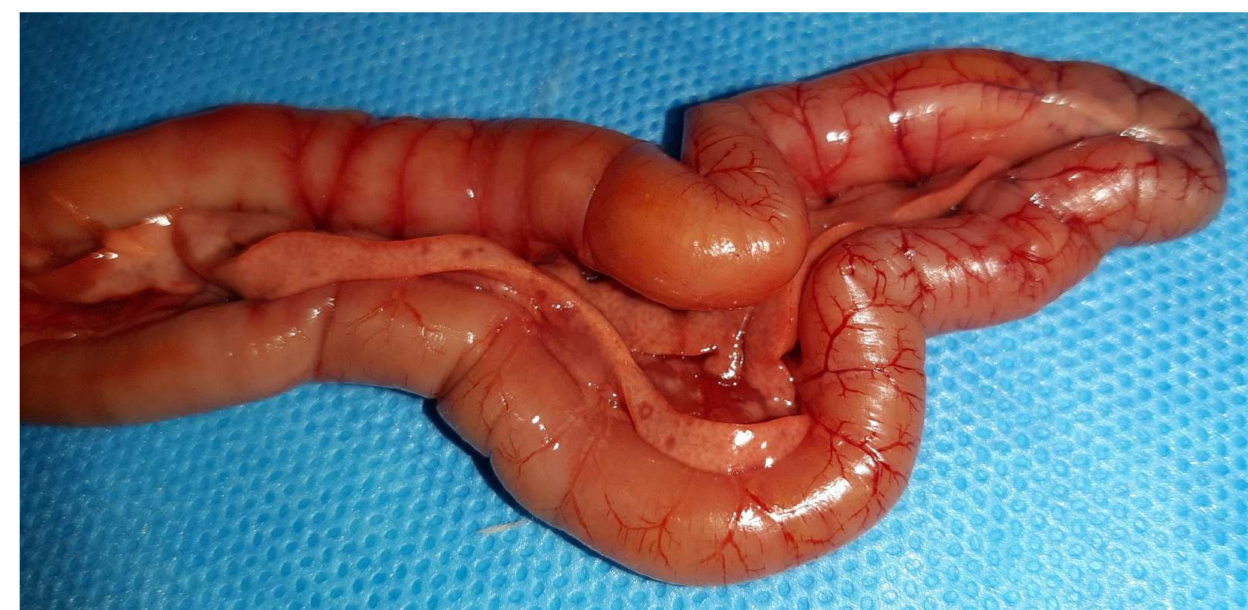
Figure 7. Gross-pathology findings on the pancreas of a 23-day-old broiler chicken, which was submitted for postmortem examination in the Unit of Avian Medicine, Thessaloniki, Greece during the IBH outbreak. The presence of necrotic spots and hemorrhage or/and congestion are visible on the surface of the